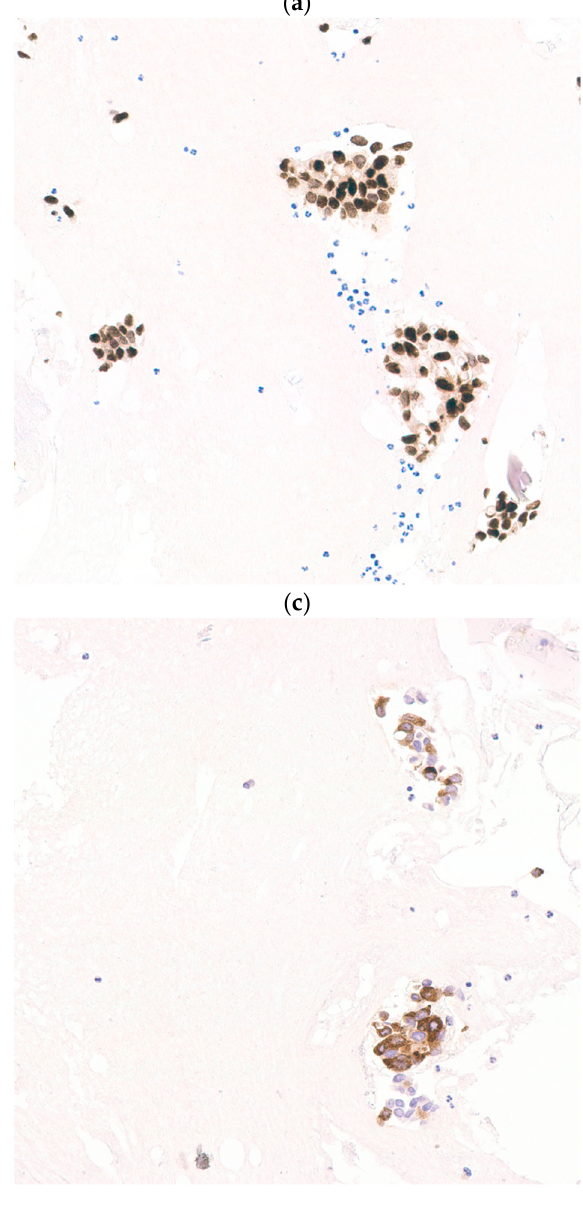
Figure 3. Expressions of GATA3, gross cystic disease fluid protein-15 (GCDFP15) and mammaglobin are positively correlated. Metastatic breast cancer showing GATA3 ( a ) (GATA3, 200× magnification), GCDFP15 ( b ) (GCDFP15, 200× magnification) and mammaglobin ( c ) (mammaglobin, 200× magnification) co-expression.